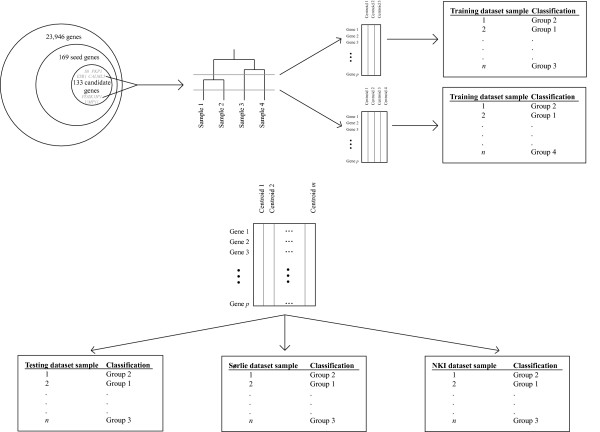
Steps of the procedure. Pictorial representation of steps 1 – 5 described in the Procedure subsection of the Methods section. (Upper) Filter all 23,946 genes by removing genes with at least 10% missing data or a standard deviation less than 1.5. Keep all seed genes that define two training dataset sample groups between which at least one of the 23,946 genes is significantly differentially expressed. Repeatedly do the following steps. Select two of the 133 candidate genes and hierarchically cluster the training dataset sample on these two genes. Cut the dendrogram from the top down to produce three groups of samples. Cut the same dendrogram from the top down again to produce four groups of samples. Use PAM to determine which of the 23,946 genes best define centroids for the training dataset sample groups obtained from the dendrogram. Form the centroids by taking only the data for those genes and averaging over the sample classified to the same group. Use the centroids to classify the training dataset samples. (Lower) If all the groups are validated in the training dataset then use the centroids to classify the testing datasets' samples. If all the groups are validated in all of the validation datasets, then the significance of the groups' clinical difference is determined (not pictured).